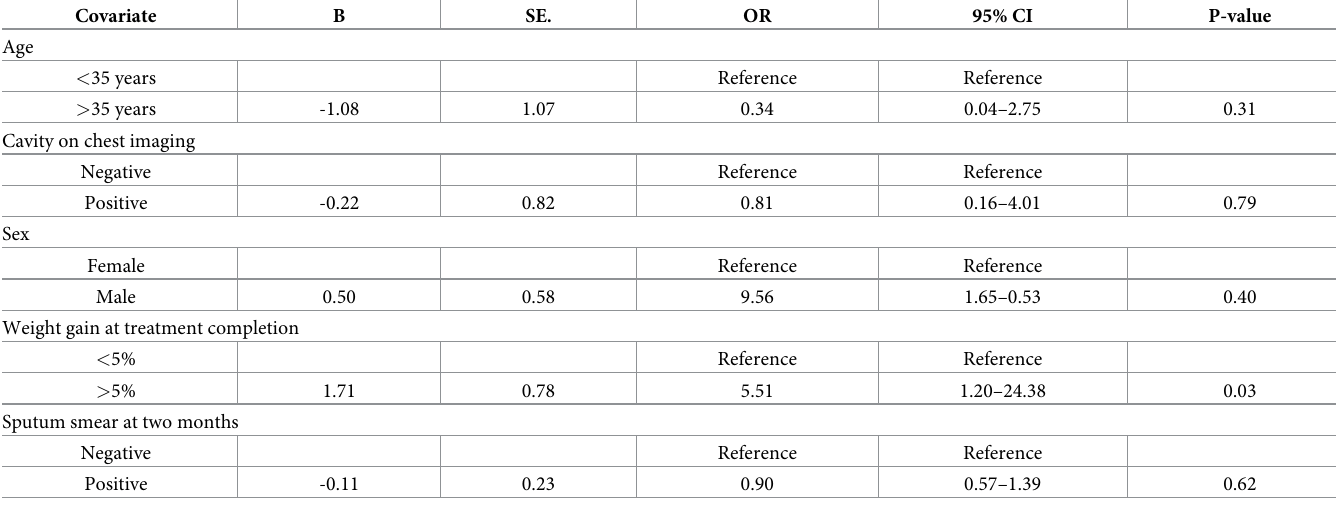
Table 3. Binary logistic regression model for predictors of the development of diabetic range hyperglycemia (HbA1c � 6.5%) at treatment completion in the nor- moglycemia and prediabetes groups.